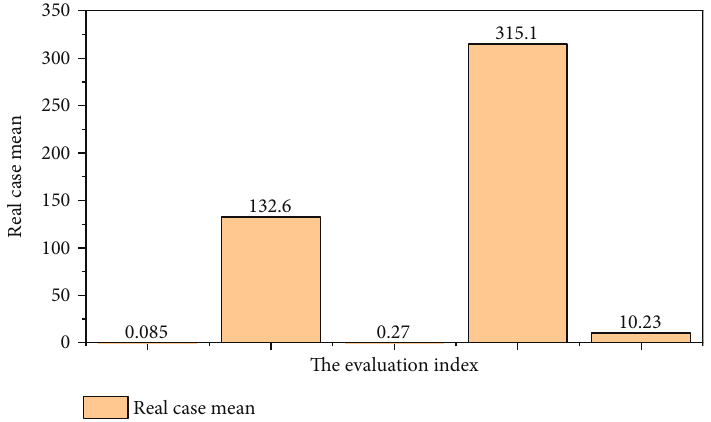
Figure 7: Performance comparison of real cases and generated results on the average value of real